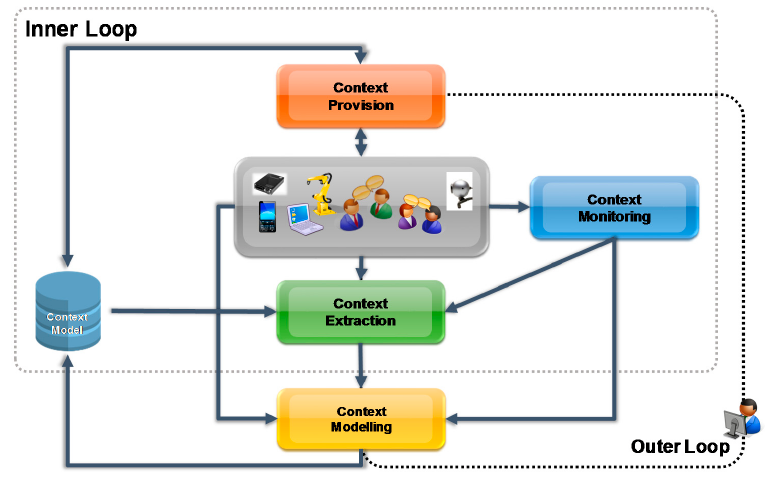
Figure 1. Context Sensitivity Concept.